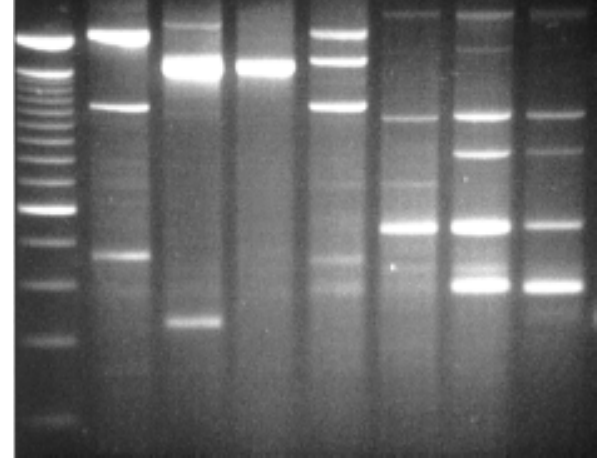
Fig. 2. Fragment lengths (bp) obtained after amplifica- tion with GT-primer. From left to right: 100 bp DNA